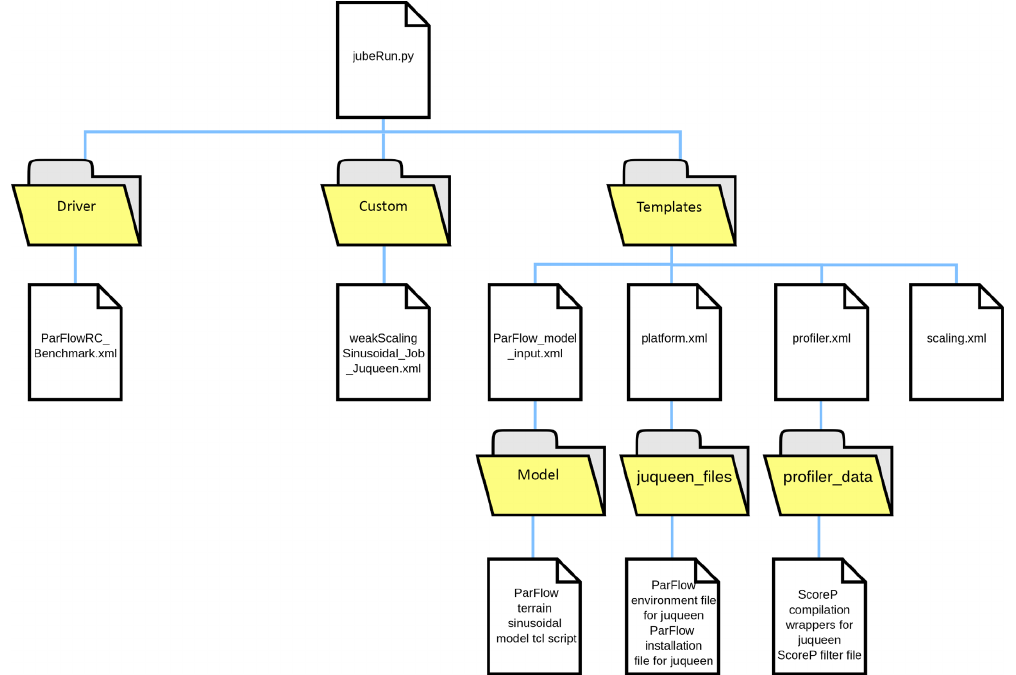
Figure 2. Directory structure of the run control framework used in the case study (Sect.